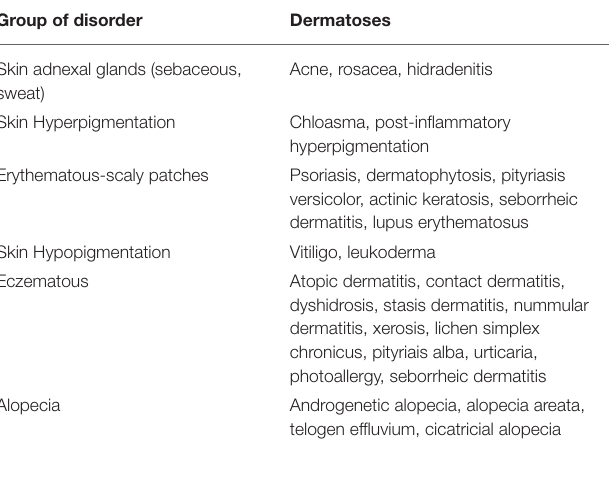
TABLE 1 | Group of skin disorders and respective dermatoses present in this study considered as partial agreement between in-person dermatologists’ and teledermatogists’ diagnosis.